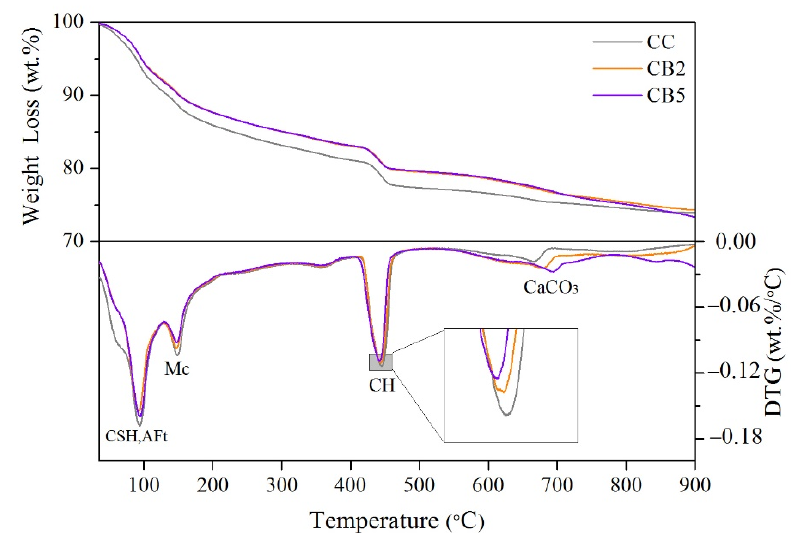
Figure 7. TG and DTG curves of specimens from 20 to 900 °C. Table 6. TG weight loss percentages of CC, CB2 and CB5. Table 6. TG weight loss percentages of CC, CB2 and